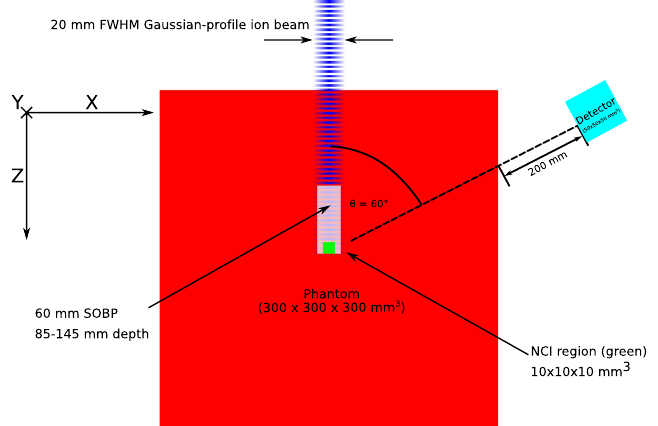
Figure 1. Schematic of the simulation configuration.